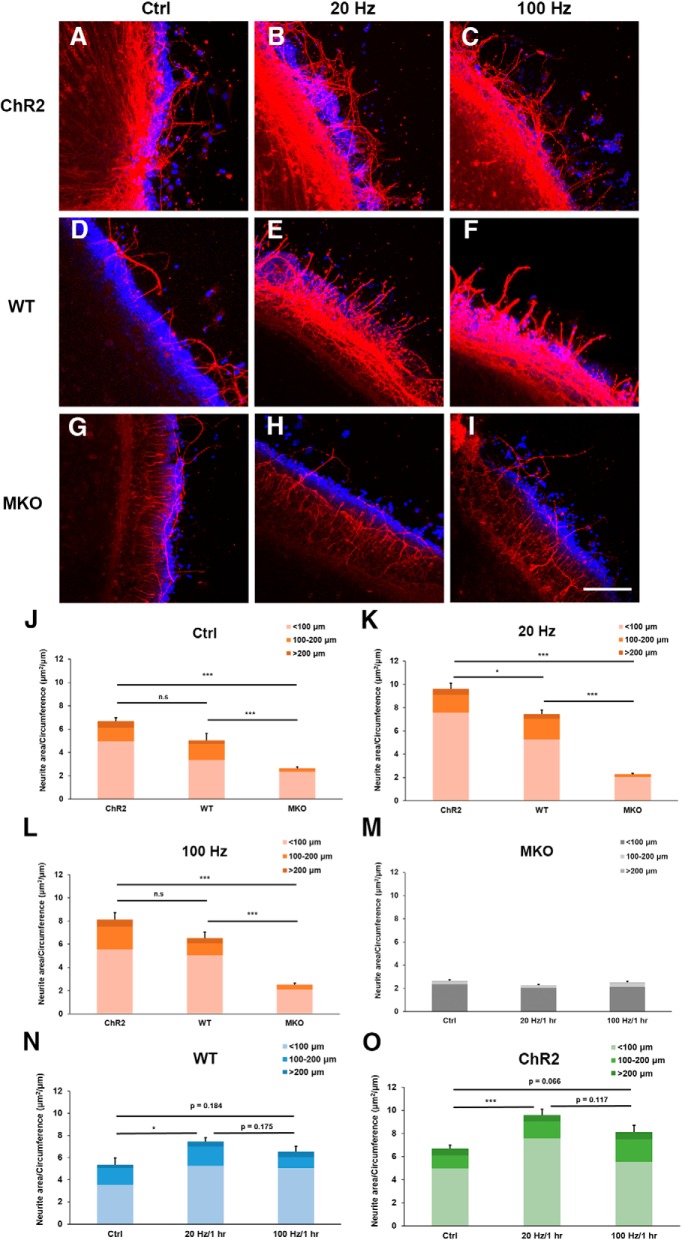
Activation of ipRGCs via blue light stimulation further enhances neurite outgrowth of retinal explants from P11 mice. A–C, Confocal images of the P11 retinal explants from ChR2 mice at DIV 5 with no stimulation (Ctrl), and with 20 and 100 Hz light stimulation for 1 h at the beginning of the experiment. D–F, Confocal images of P11 retinal explants from WT mice at DIV 5 with the same treatments as above. G–I, Confocal images of P11 retinal explants from MKO mice at DIV 5 with the same treatments as above. Recognized neurites were TUJ1-positive (red), and DAPI was used to label the nuclei (blue). Scale bar, 100 μm. J, Neurite outgrowth of P11 retinal explants was significantly different when mice with three different genetic backgrounds (ChR2, WT, and MKO) were compared, even without blue light stimulation (n = 7 for ChR2; n = 5 for WT; n = 6 for MKO). K, Neurite outgrowth of P11 retinal explants was significantly better for ChR2 mouse retinas than for WT mouse retinas when there was 20 Hz blue light stimulation; furthermore, the neurite outgrowth was significantly reduced in MKO mice (n = 9 for ChR2; n = 5 for WT; n = 6 for MKO). L, A similar trend was found for P11 retinal explants with 100 Hz light stimulation (n = 6 for ChR2; n = 5 for WT; n = 6 for MKO). M, When ipRGCs and ChR2-RGCs were absent in the MKO mice, neurite outgrowth of P11 retinal explants was significantly poorer under all three conditions (no stimulation, 20, and 100 Hz blue light stimulations). N, O, Similar comparison schemes indicate that 20 Hz blue light stimulation enhanced neurite outgrowth more significantly than the ones without light stimulation for both WT and ChR2 mice, respectively. n.s, p > 0.05; *p < 0.05; ***p < 0.001. Error bars, mean ± SEM.